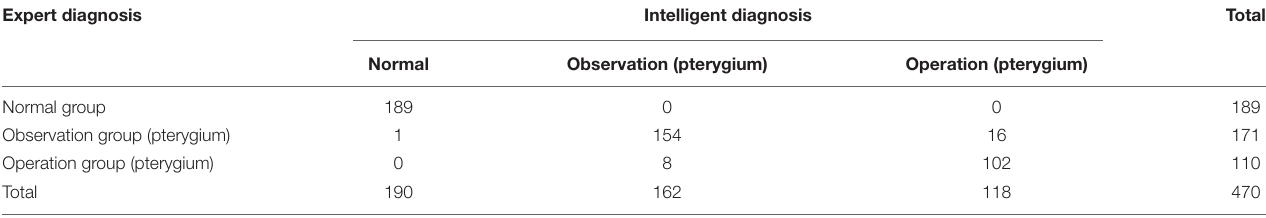
TABLE 1 | Diagnostic results.